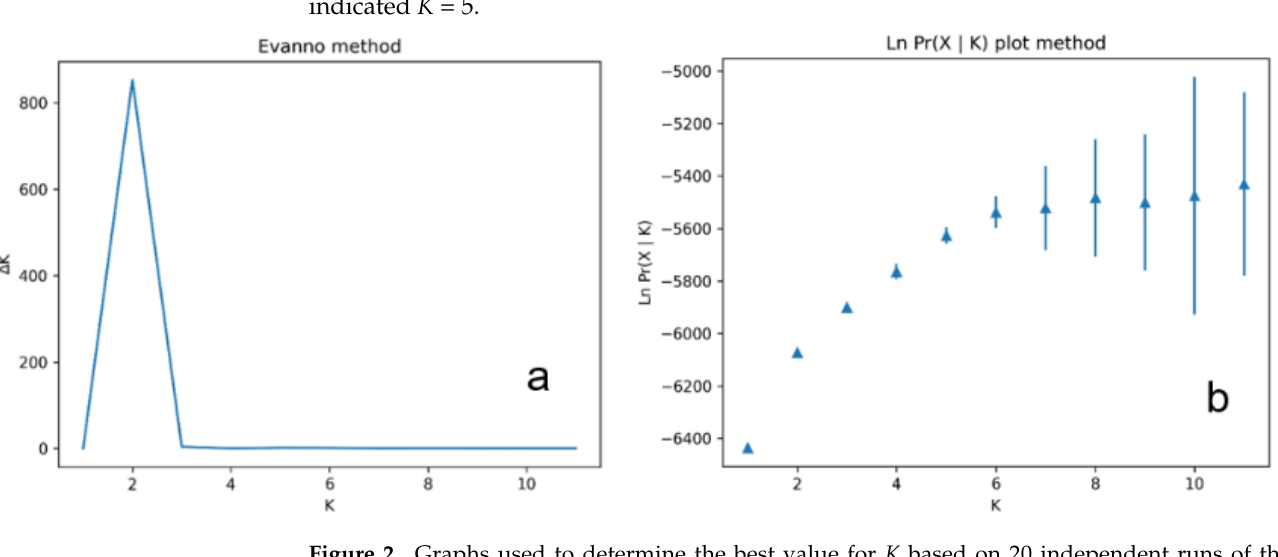
Figure 2. Graphs used to determine the best value for K based on 20 independent runs of the STRUCTURE program. ( a ), Evanno method; ( b ), Ln Pr (X | K ) plot method, in which the vertical blue lines represent the standard deviation.